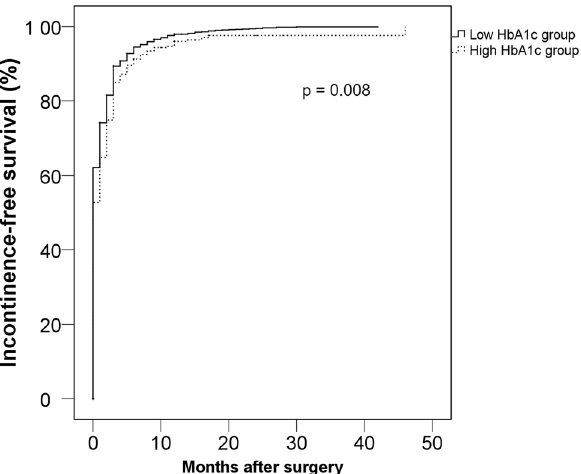
Figure 2. Kaplan–Meier analyses on the recovery of urinary incontinence according to the preoperative HbA1c.